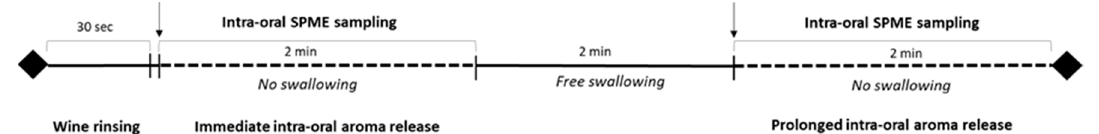
Figure 1. Sampling procedure followed for oral aroma monitoring. 84